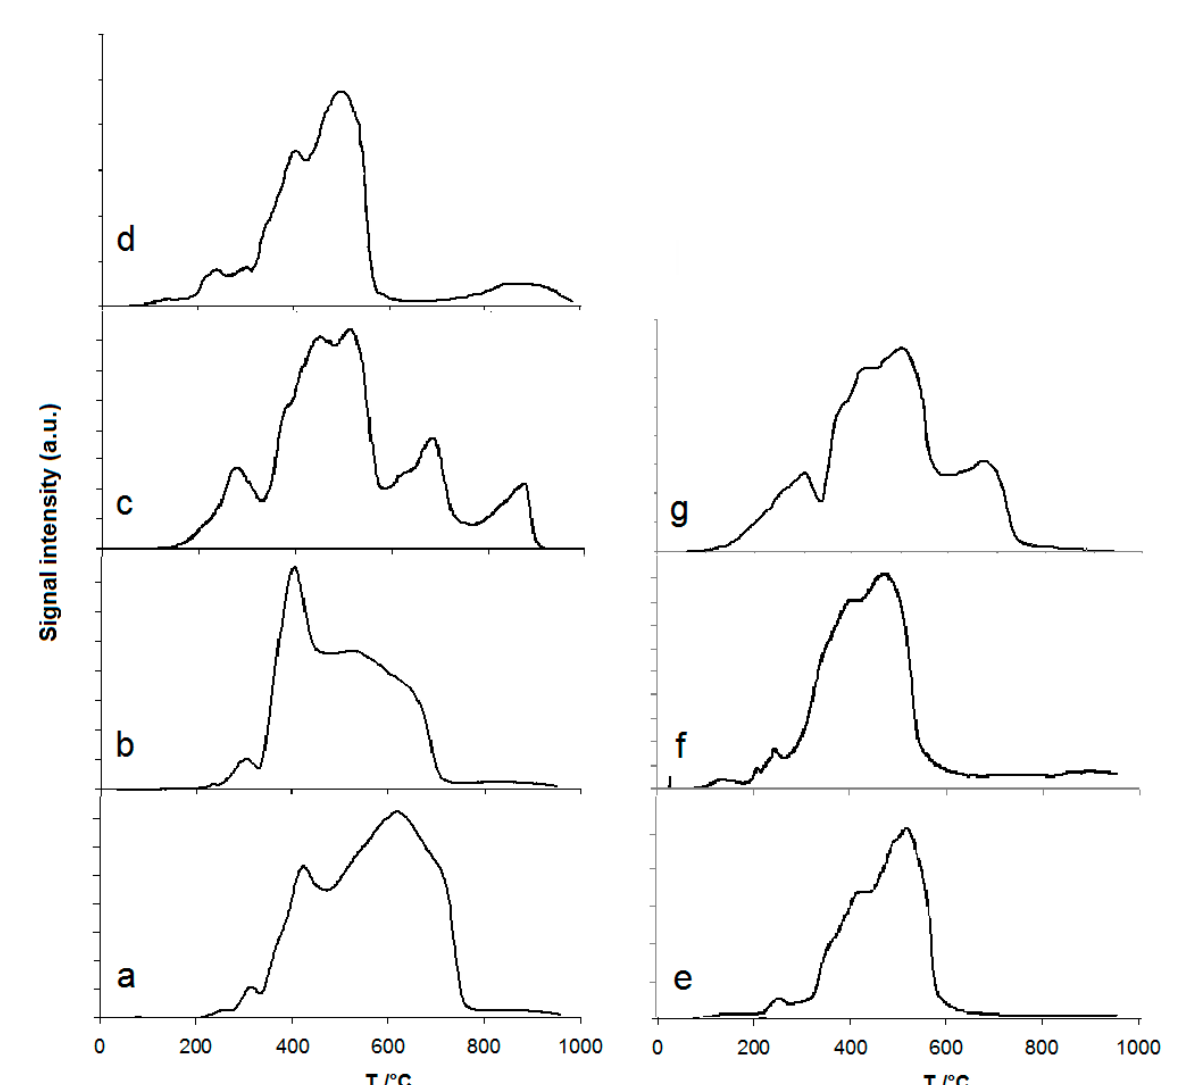
Figure 5. Temperature programmed reduction (TPR) patterns of the FP-prepared catalysts. Signal intensity in arbitrary units. ( a ) La 0.3 Zr 0.7 NiO 3 ; ( b ) 10 wt% Ni/(0.3La 2 O 3 –0.7ZrO 2 ); ( c ) La 0.8 Sr 0.2 NiO 3 ; ( d ) CeNiO 3 ; ( e ) La 0.3 Ce 0.7 NiO 3 ; ( f ) 10 wt% Ni/(0.3La 2 O 3 –0.7CeO 2 ); ( g ) LaNiO 3 .